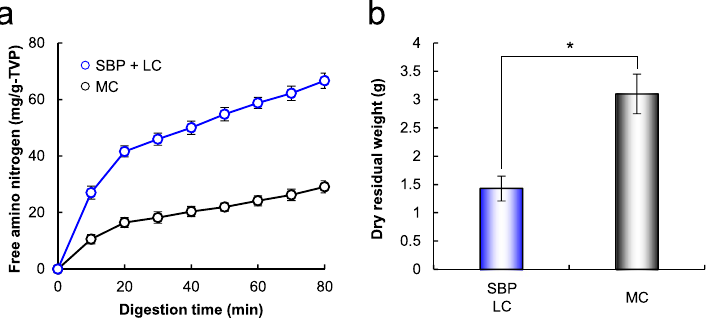
Figure 5. In-vitro gastrointestinal digestibility of meat analogs. The gastrointestinal digestion test was performed for 90 min. Free amino nitrogen released from meat analogs ( a ) was measured using the ninhydrin method, and then its dry residual weight ( b ) was measured. Data are presented as mean ± standard deviation of three experiments. * p < 0.05, Student’s t-